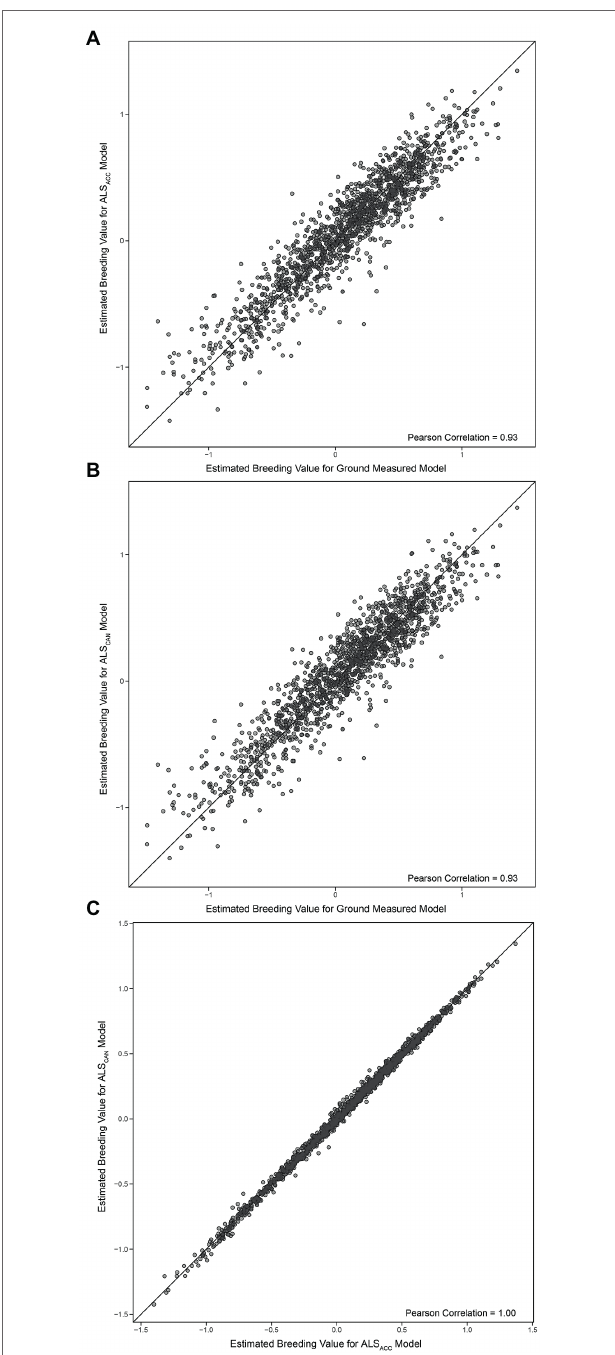
FIGURE 6 | (A) Comparison of estimated breeding values (Equation 2) for the final ground-based model and the most accurate ALS-based model (ALS ACC ). (B) Comparison of estimated breeding values (Equation 2) for the final ground-based model and the candidate ALS-based model (ALS CAN ). (C) Comparison of estimated breeding values (Equation 2) for both ALS models. The black line represents a 1:1